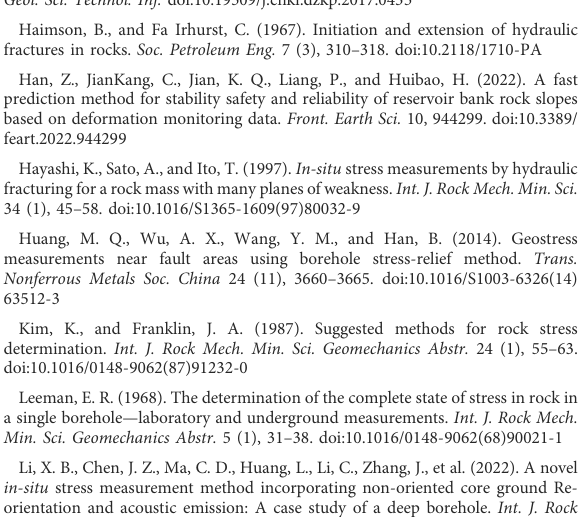
shaking table tests. Eng. Geol. 245, 153 – 168.